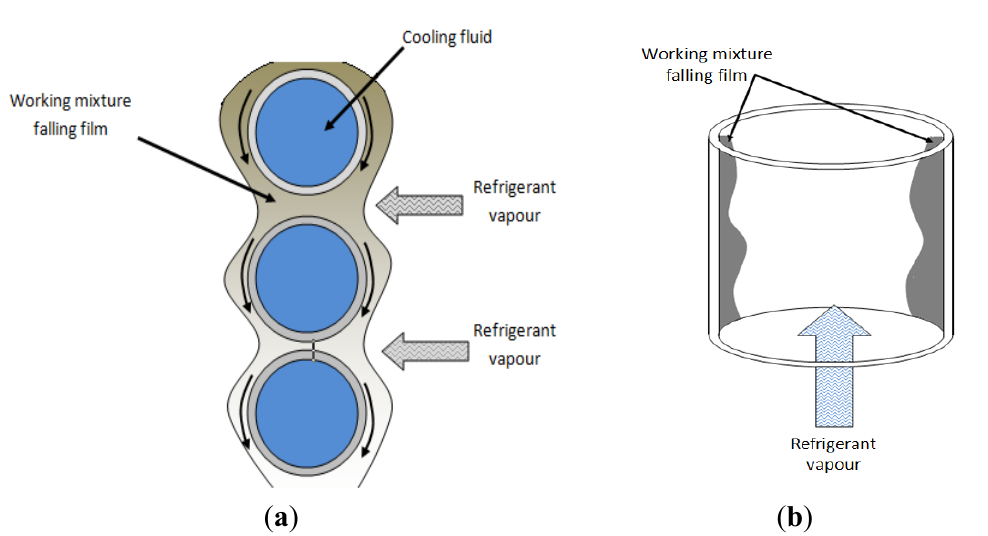
Figure 2. Falling film absorber configurations: ( a ) horizontal bank tube and ( b ) vertical